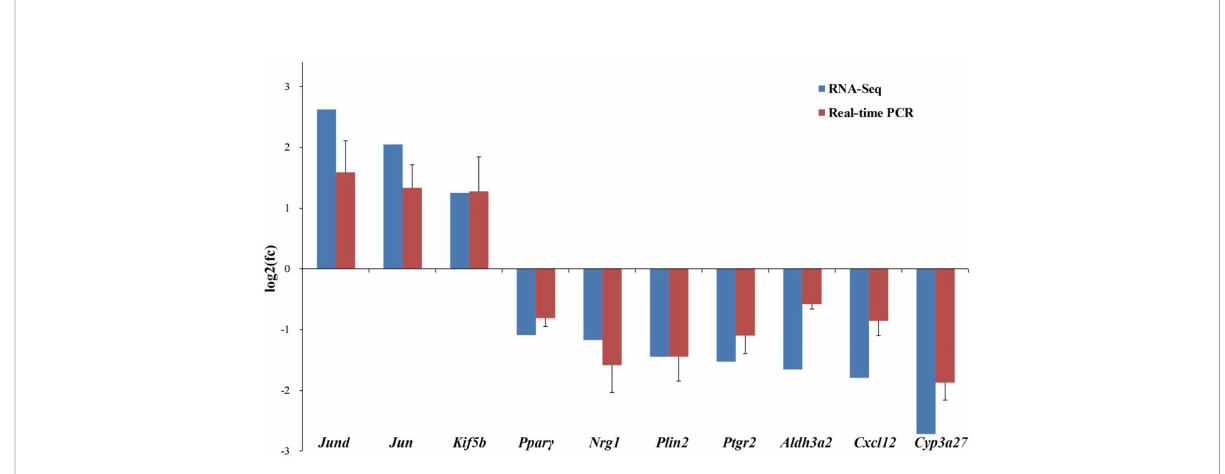
FIGURE 5 Comparison of gene expression data between RNA-Seq and Real-time PCR in the ovary of adult spotted scat fed with different oil sources. Data are presented as means ± SE. (n = 10), analyzed using T-test for independent